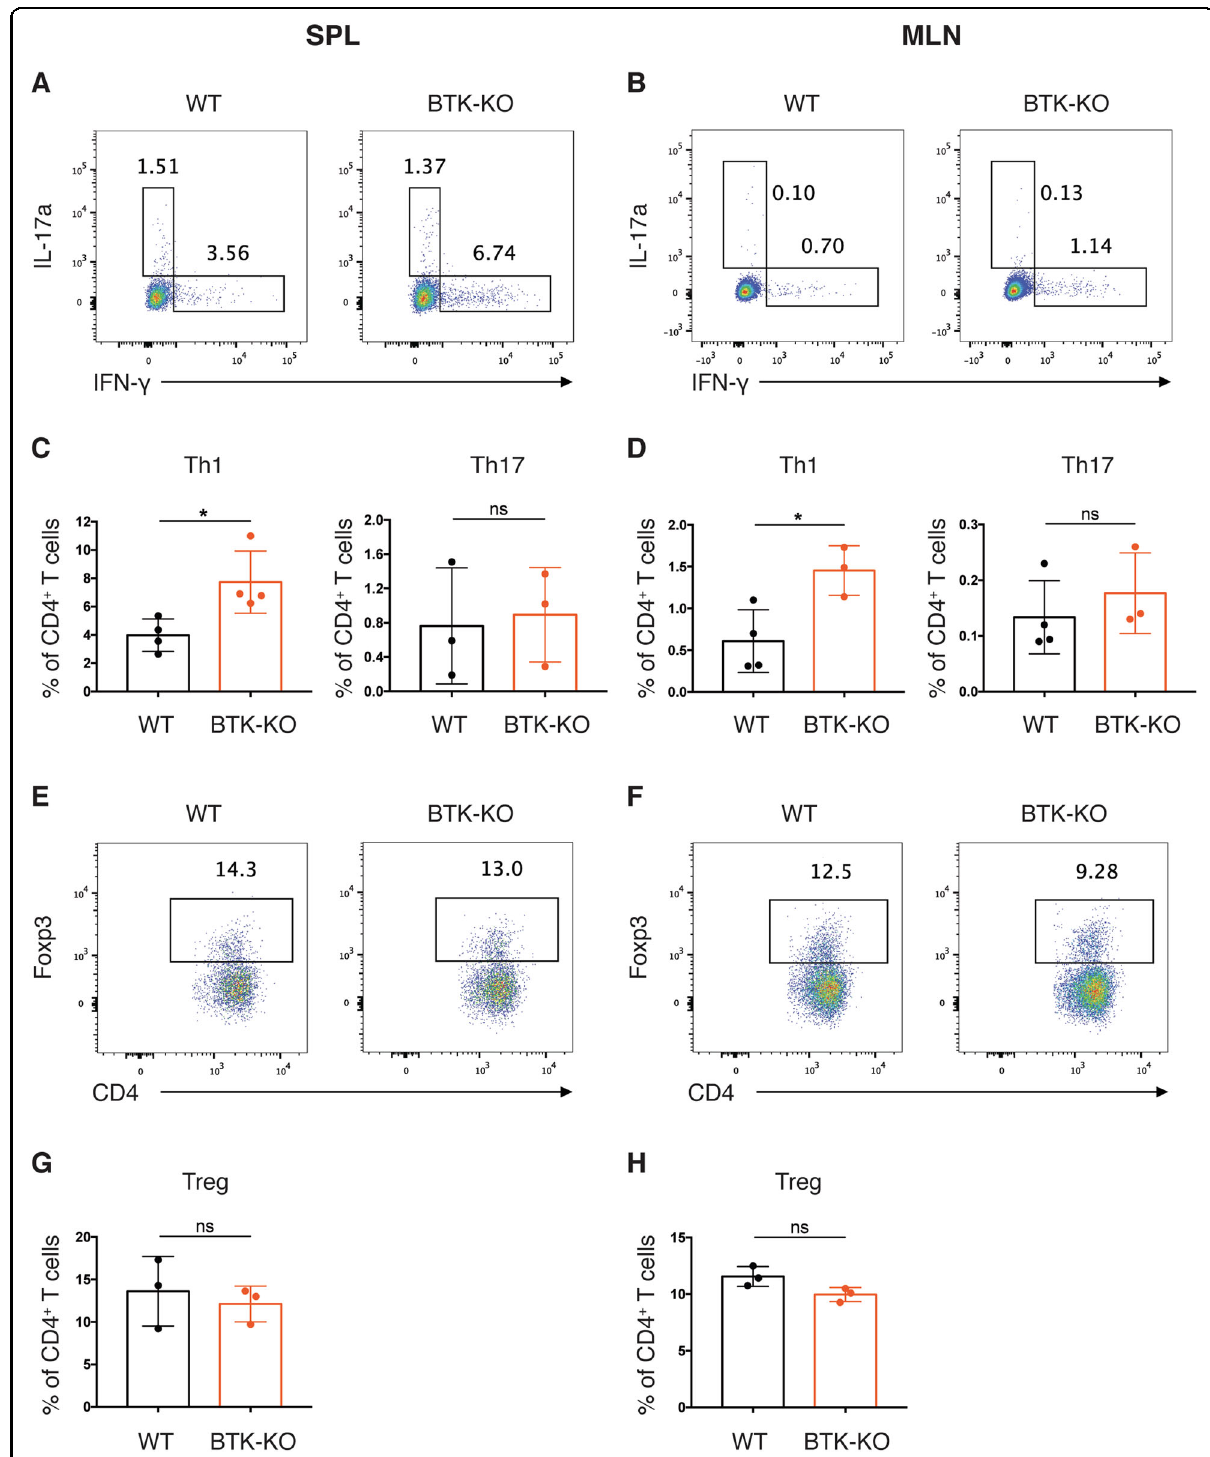
Fig. 5 Increased differentiation of Th1 cells in lymphoid tissues of BTK-KO mice. CD4 + T cells from spleen ( A ) and MLNs ( B ) of WT and BTK-KO mice stained as indicated to reveal Th1 (IFN- γ + ) and Th17 (IL-17a + ) cells. Numbers shown are percentage of cells in the indicated gates. C , D Frequency of Th1 and Th17 cells in CD4 + T cells from the spleen ( C ) and MLNs ( D ) of WT and BTK-KO mice. E , F CD4 + T cells from spleen ( E ) and MLNs ( F ) of WT and BTK-KO mice stained as indicated to reveal Tregs (Foxp3 + ). Numbers shown are percentage of cells in the indicated gates. G , H Frequency of Treg cells in CD4 + T cells from the spleen ( G ) and MLNs ( H ) of WT and BTK-KO mice. SPL: spleen. MLN: mesenteric lymph node. Data are presented as mean ± SD ( n = 3 – 4). Statistical signi fi cance was determined by two-sided independent sample Student ’ s t test. ns: not signi fi cant; * P < 0.05, ** P < 0.01 and *** P <